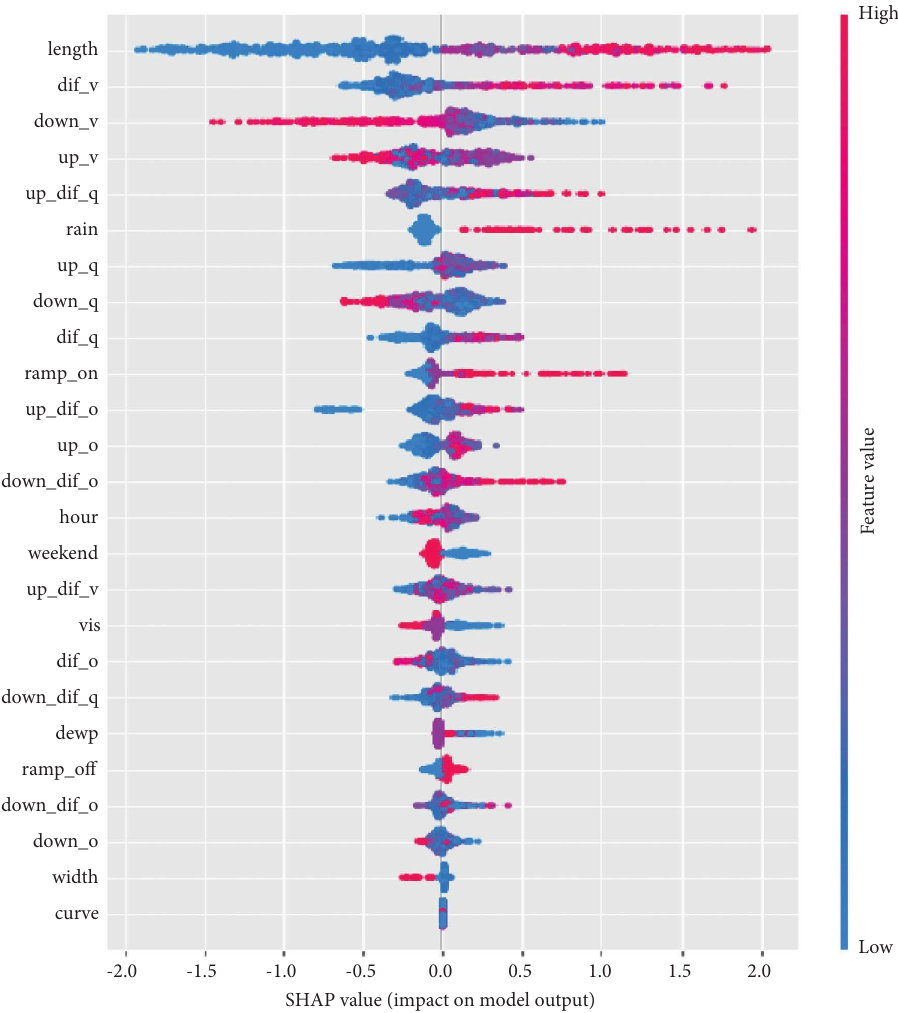
Figure 6: SHAP summary